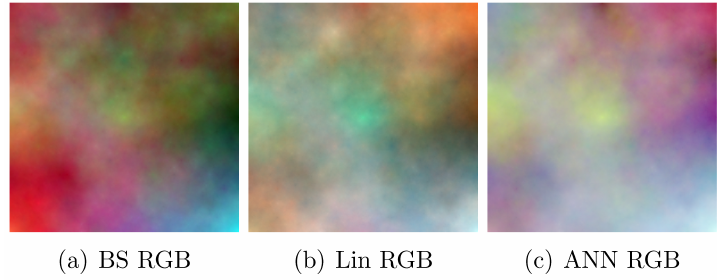
Figure 5. The RGB color composite images of the MSFI in Figure 4a.